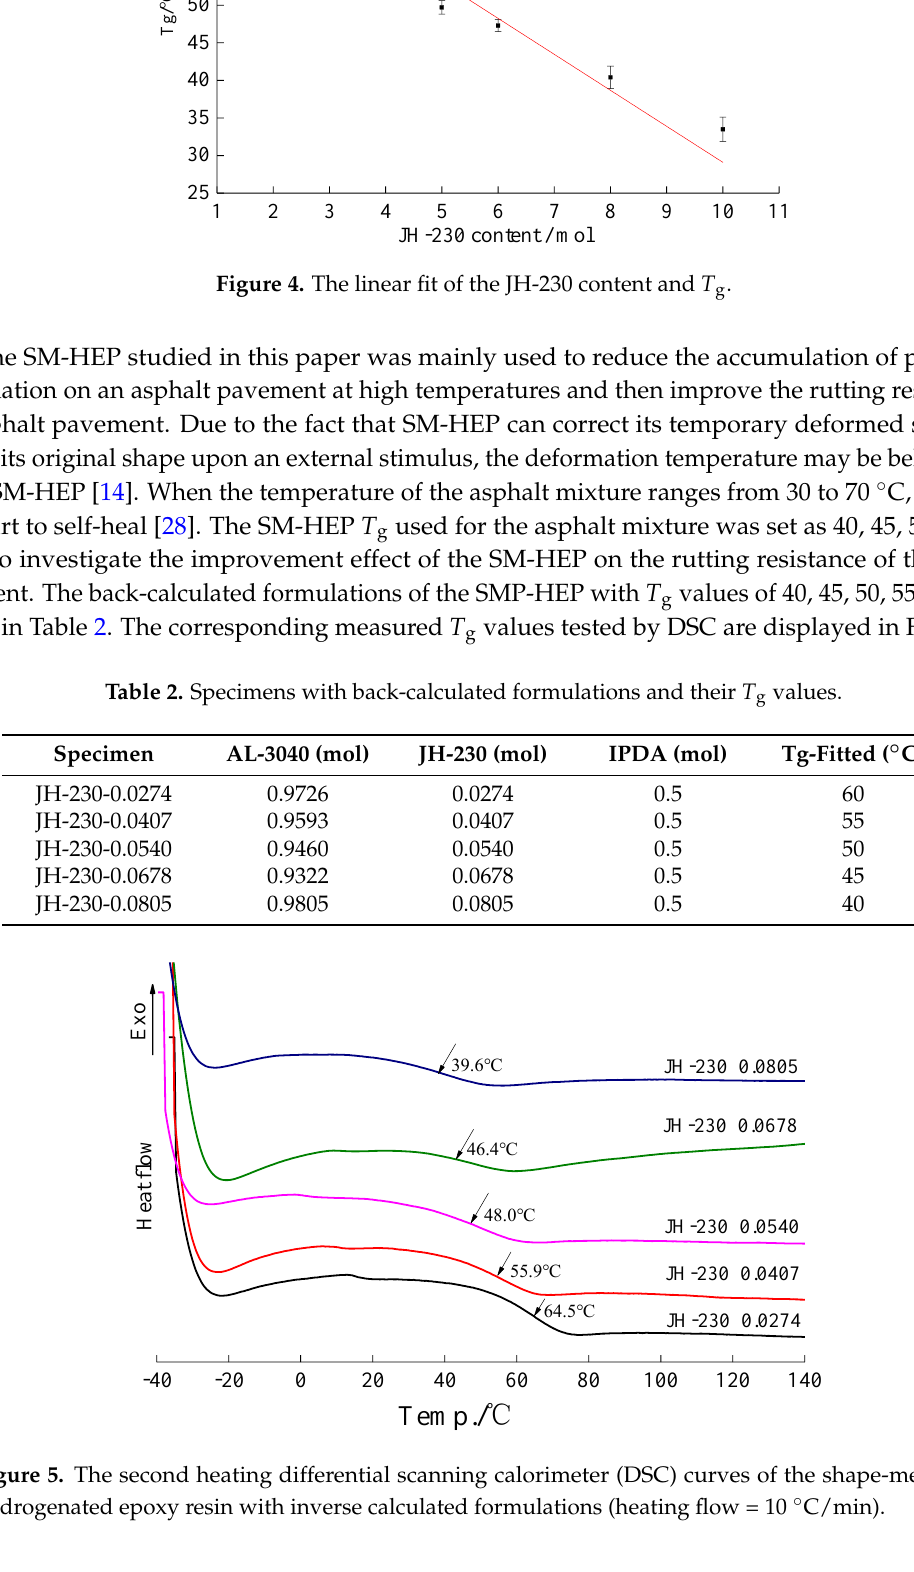
Figure 4. The linear fit of the JH-230 content and T g .